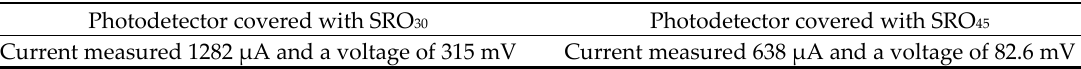
Table 1. Currents and voltages measured for photodetectors with SRO 30 and SRO 45 films.